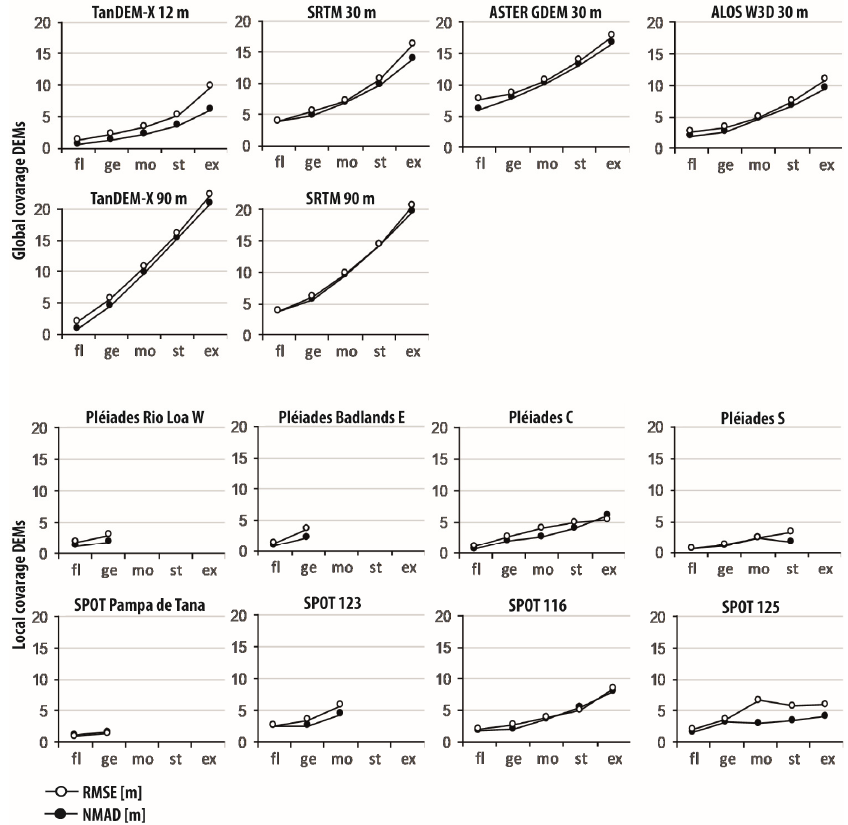
Figure 7. Calculated RMSE and normalized median absolute deviation (NMAD) of elevation di ff erences according to the slope. Derived slope classes are flat (fl), gentle (ge), moderate (mo), steep (st) and extreme